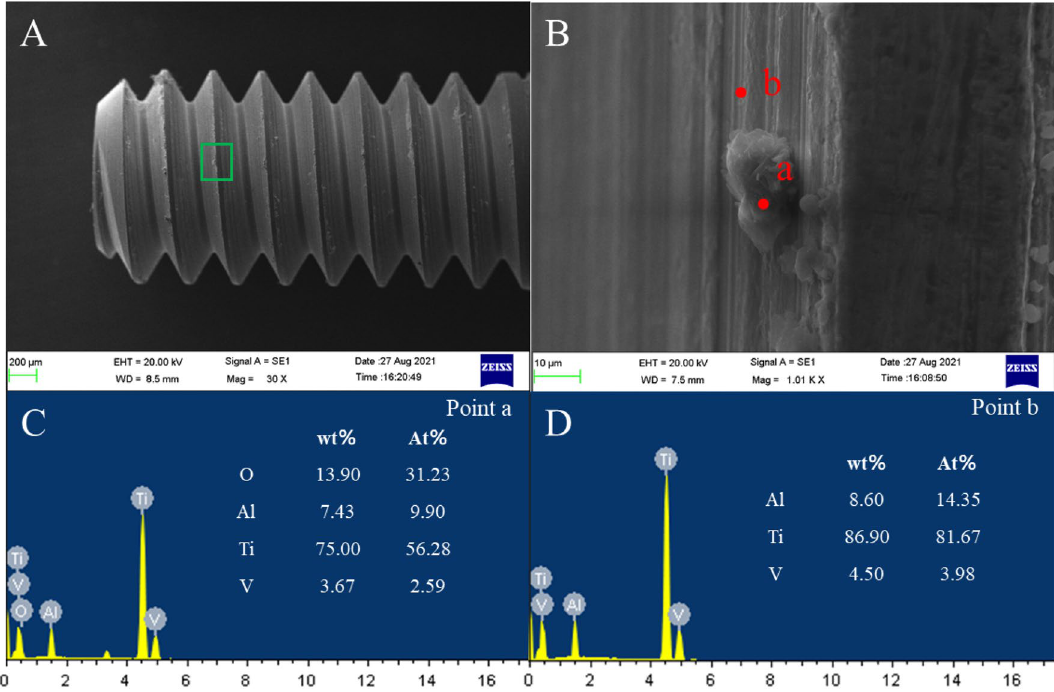
Figure 6. Screw surface wear in the NC group. ( A ) Screw morphology, ( B ) area shown in ( A ), ( C ) EDS at point (a), and ( D ) EDS at point (b).